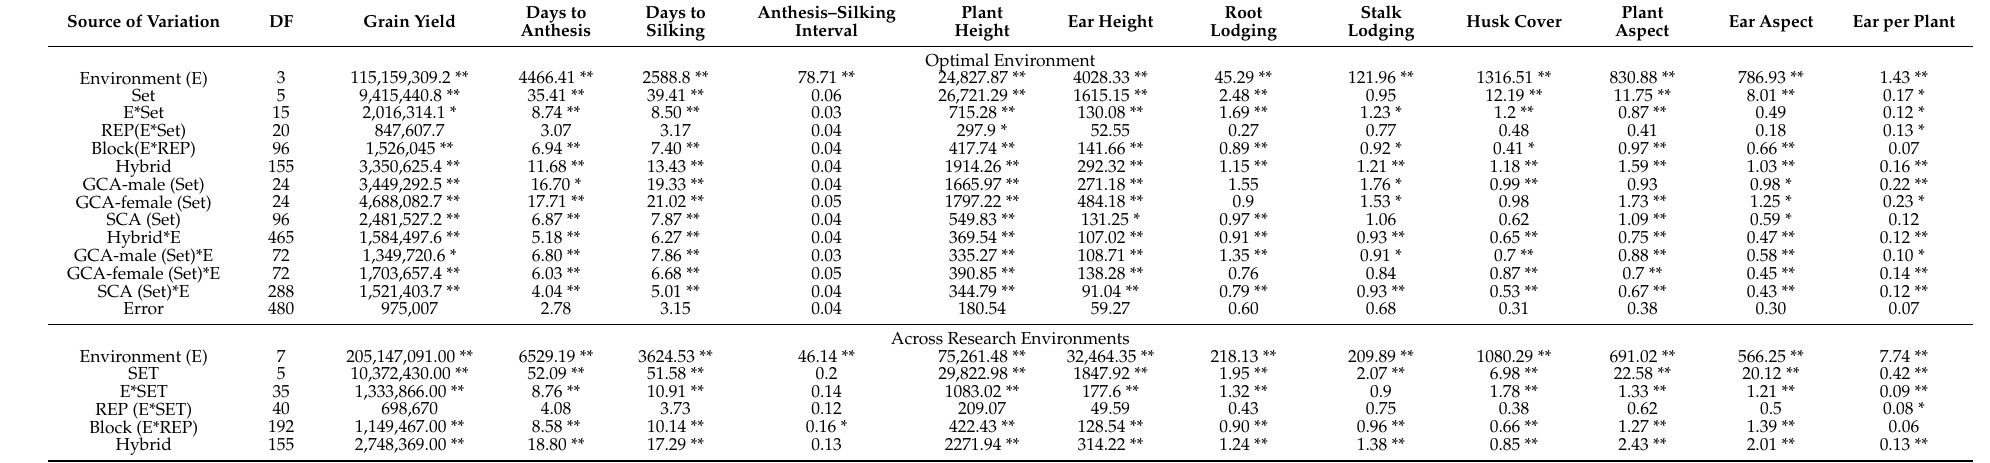
Table 3. Mean squares derived from a combined analysis of variance for grain yield and other phenotypic traits of the 150 single-cross hybrids tested under optimal growing conditions in Ghana and Nigeria in 2016 and 2017 and across eight research